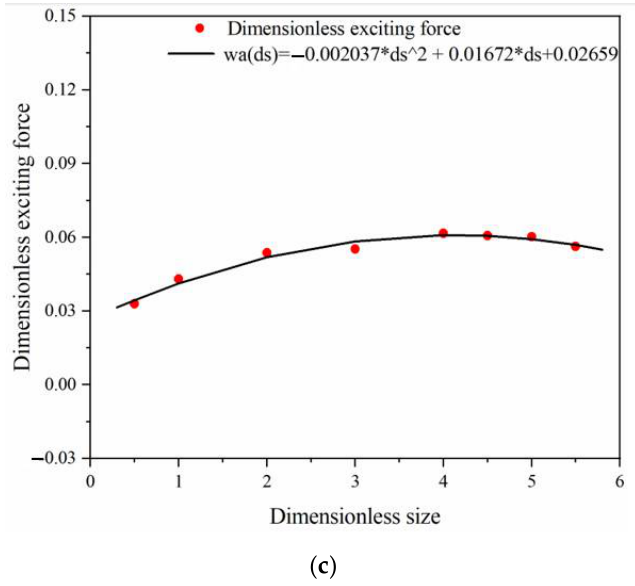
Figure 6. The mathematical expression of dimensionless relation. ( a ) Added mass. ( b ) Radiation damping. ( c ) Wave excitation force.